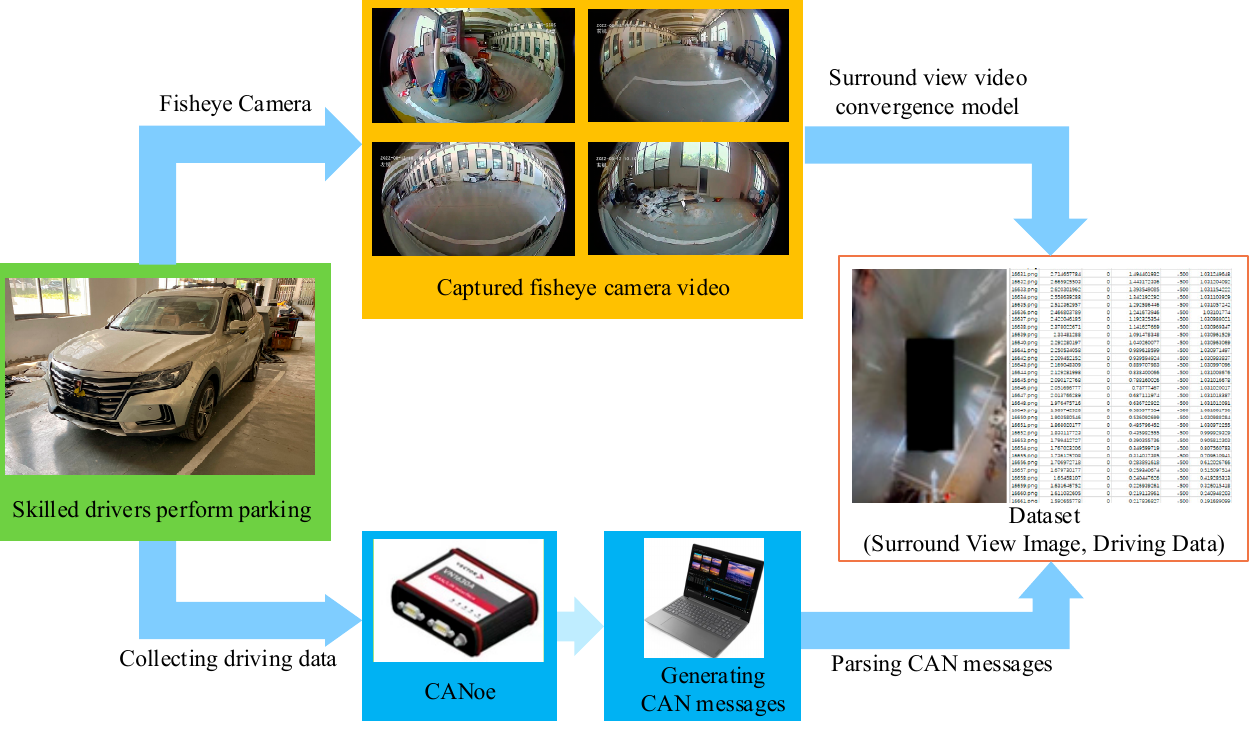
Figure 6. Actual car dataset collection process.